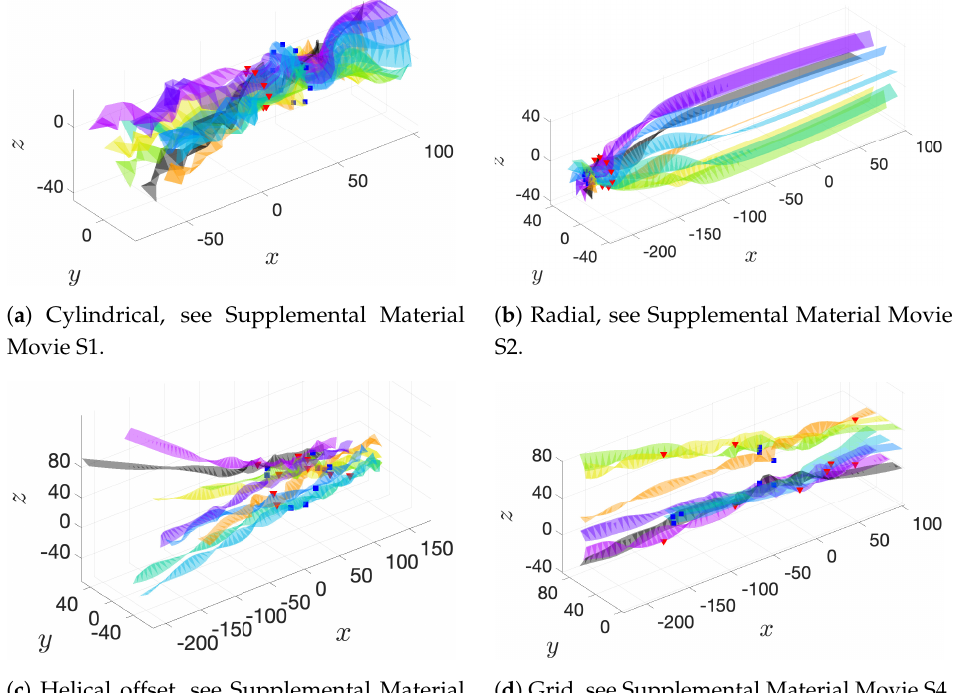
Figure 9. Ribbon path trajectories created by triangulation of head positions over each beat for the entire simulation. Due to the lateral oscillation of the flagellum head (initial point) within each beat, the head carves out a ribbon-like trajectory. This ribbon indicates the flagellar beat plane. Blue squares denote the location of flagellum head when maximal efficiency is achieved and red triangles denote the location of the flagellum head when minimal efficiency is achieved. Head positions start near x = 100 µ m and flagella move in the negative x -direction, so flagella heads start at far right and end up in the far left of each image. All units are in µ m. Colors of ribbons correspond to the flagellum of the same color from the initial configurations in Figure